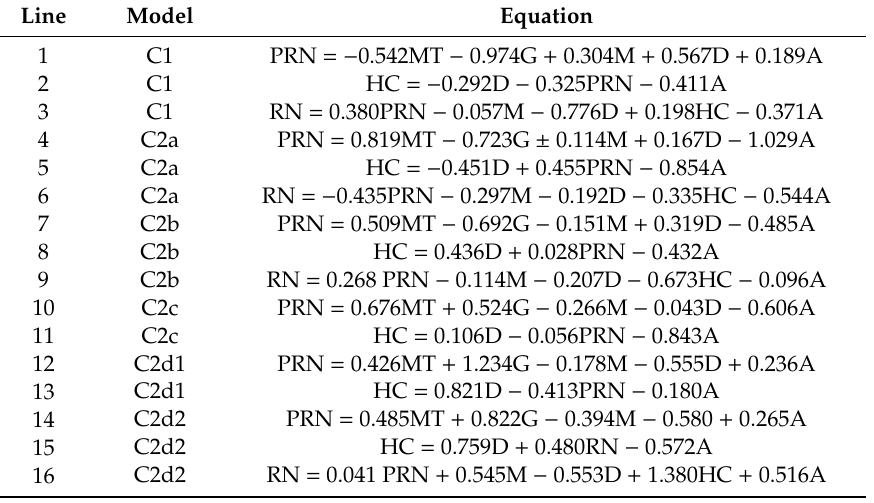
Table 3. Equations developed by PLS-PM models to represent the relationships between measured, exogenous, and endogenous latent